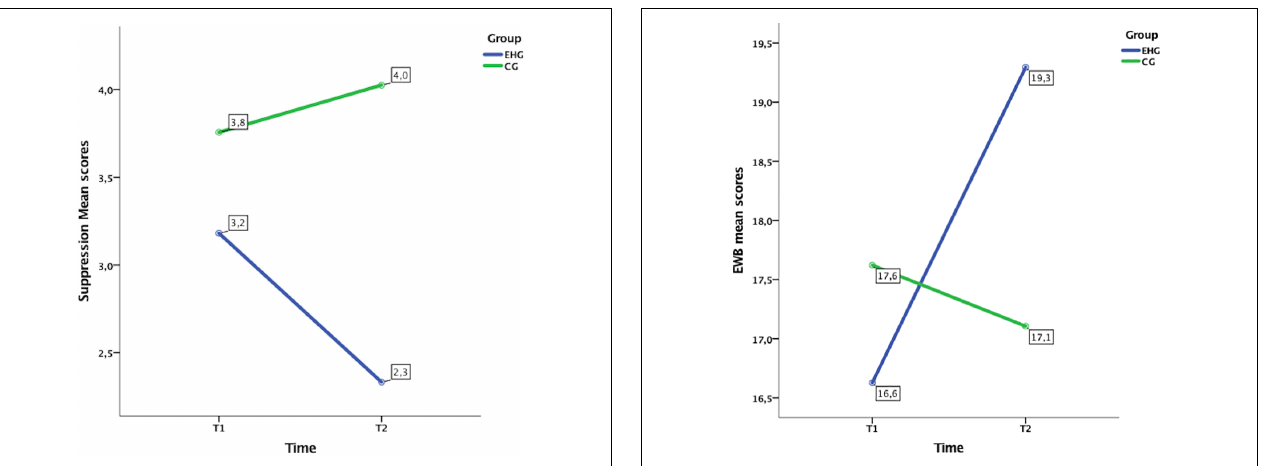
FIGURE 3 | Emotional Suppression significant interaction effect time × group from ANCOVA analysis.